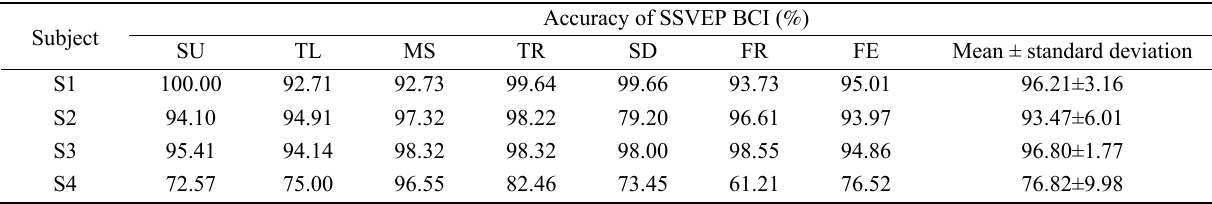
Table 2 Performance of the SSVEP